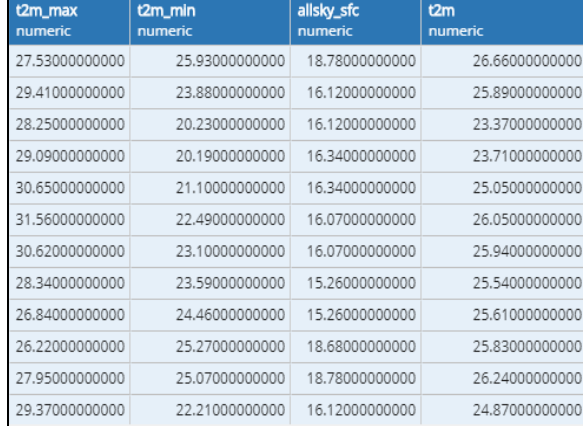
Figure 3. Weather